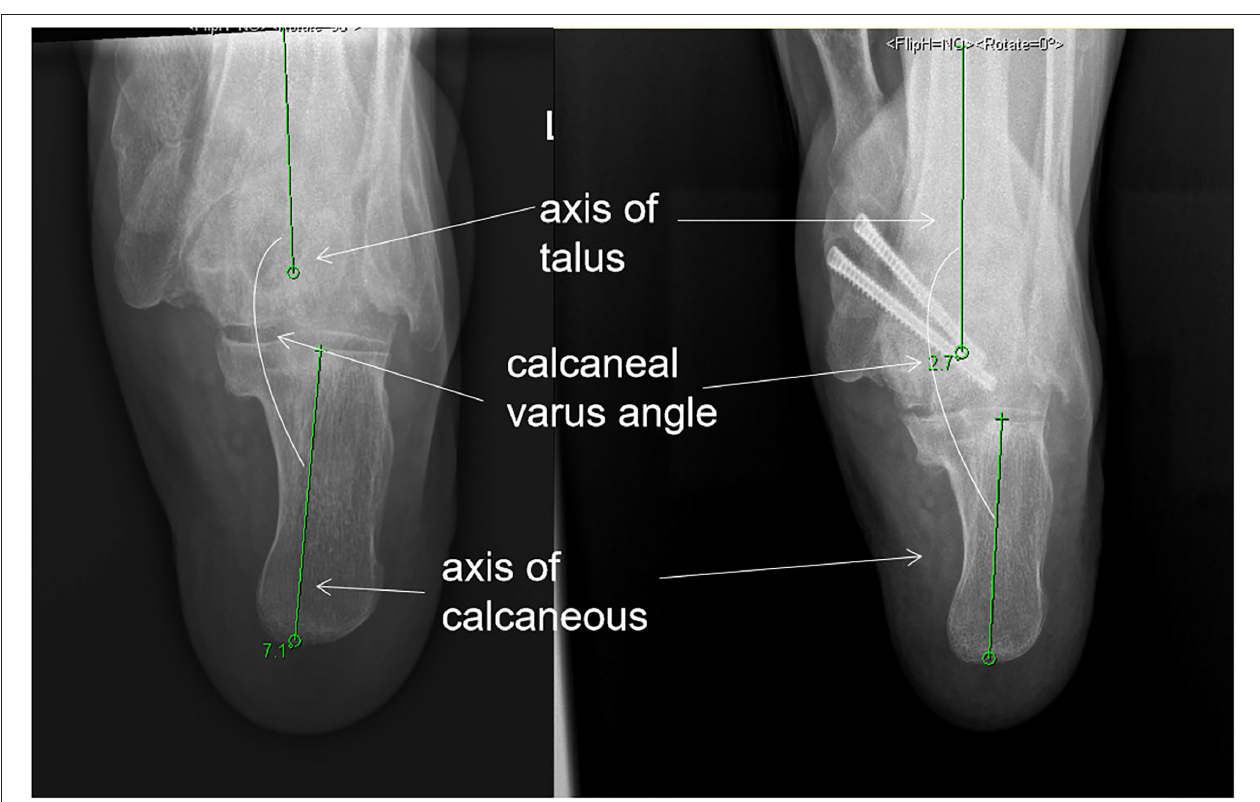
FIGURE 3 | Calcaneal varus angle: the intersection angle between the calcaneus and tibia was measured preoperatively and postoperatively in the calcaneus axis radiography. We name the novel angle the “calcaneus varus angle” (CVA) (varus = positive value, valgus = negative value). The angle, in this case, was varus , thus, it was given a positive